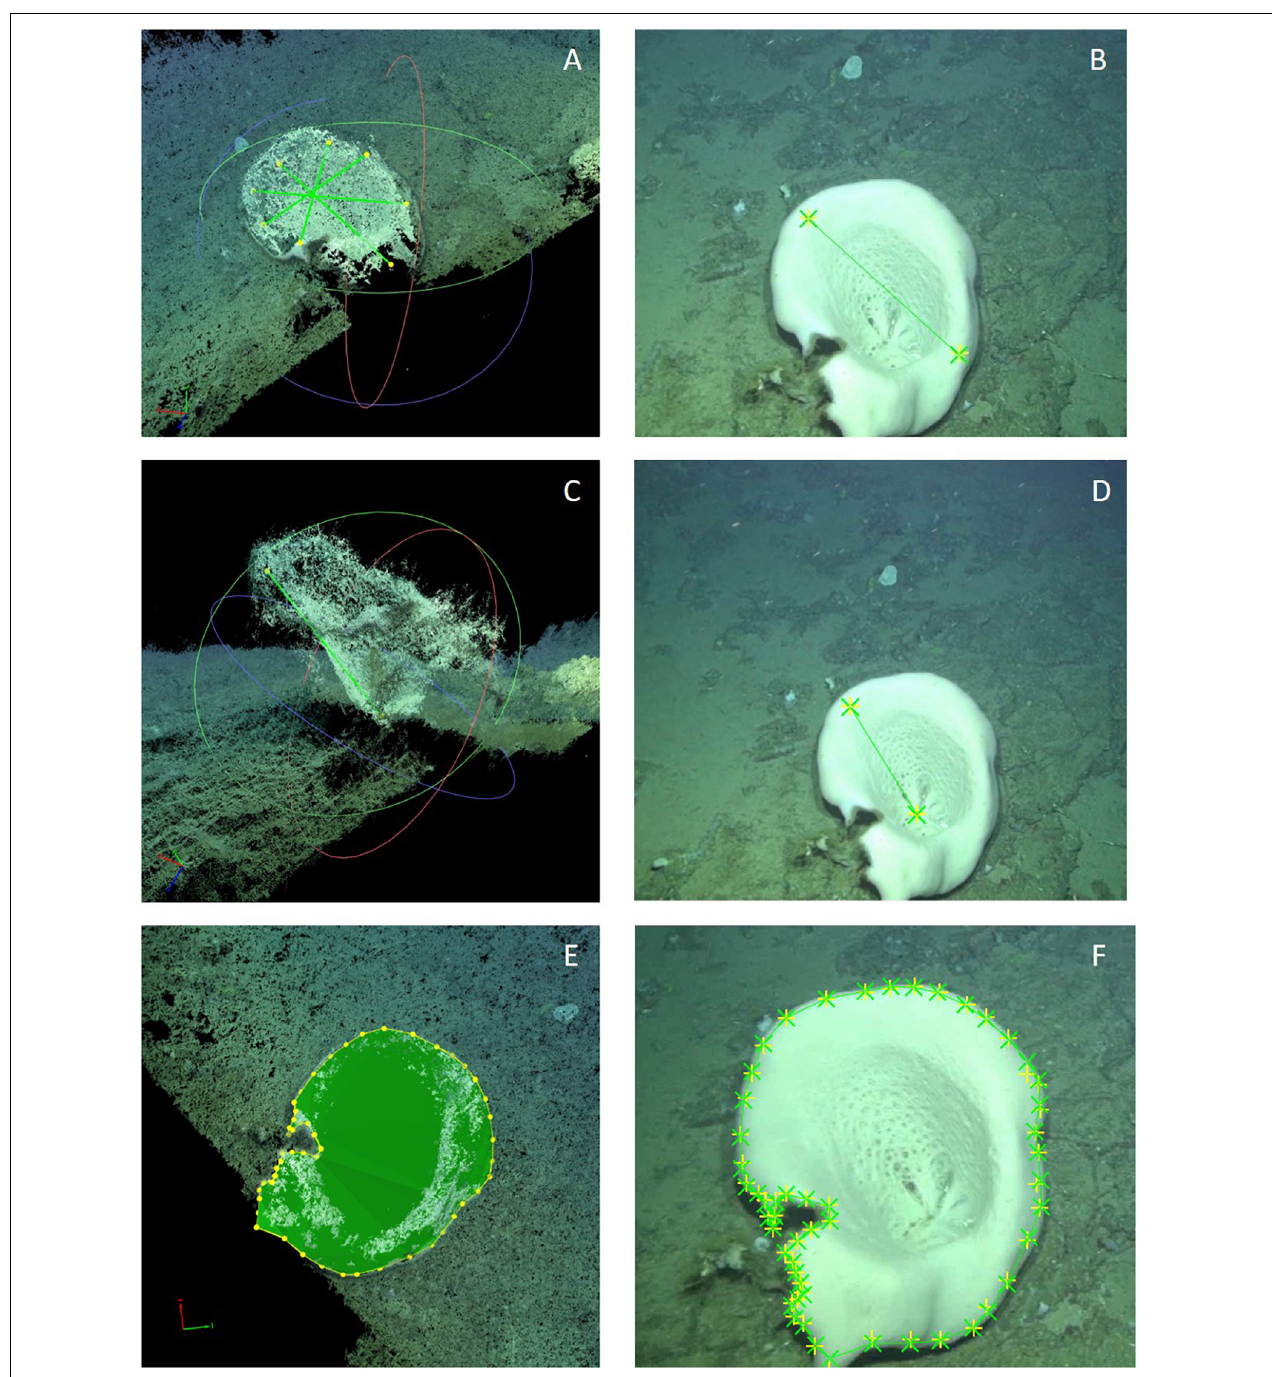
FIGURE 7 | Measurements taken to characterize the sizes of A. setubalense specimens: (A,B) Diameter; (C,D) Height; (E,F) External cup-perimeter and enclosed cup-surface area. All measurements were made on a 3D point cloud (A,C,E) ; and by correcting the position of the vertices marking them on 2D images with higher resolution (B,D,F)